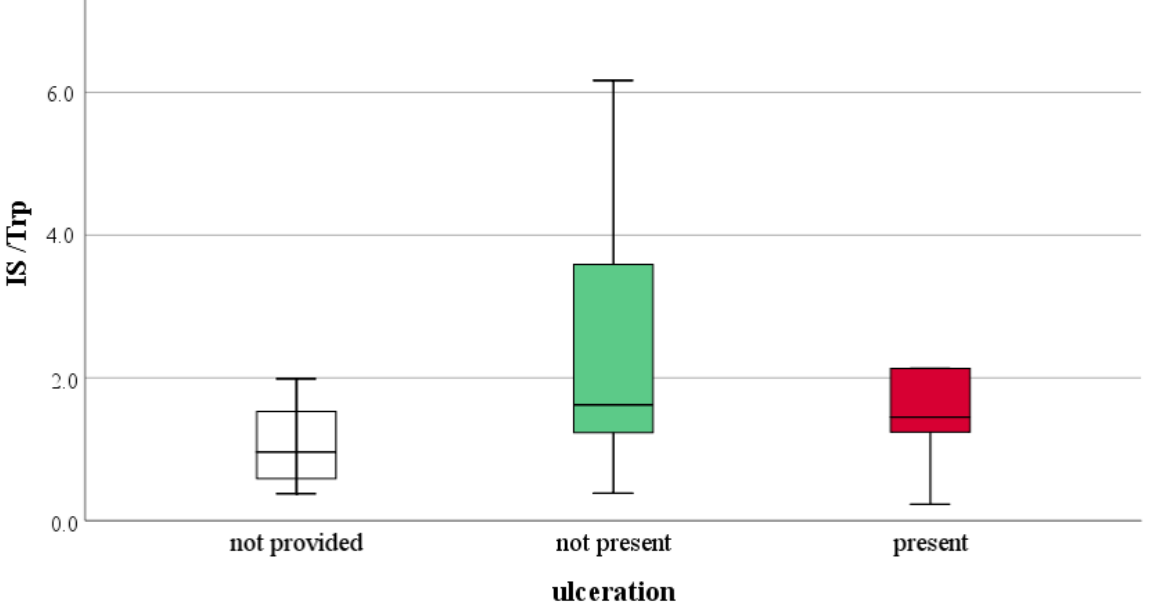
Figure 5. Comparison of indole pyruvate pathway metabolite, the indoxyl sulfate level relative to tryptophan concentration, based on the presence of ulceration , p = 0.493.